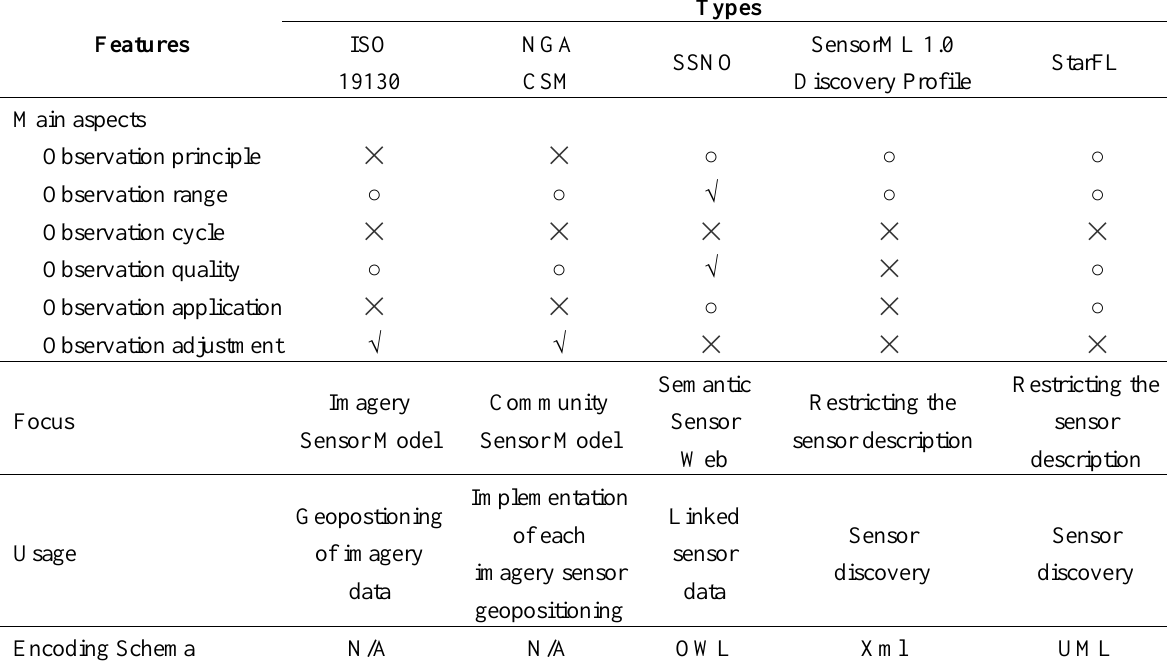
Table 2. Comparisons among existing observation capability-related metadata sets. NGA, National Geospatial-Intelligence Agency; CSM, National Geospatial-Intelligence Agency; SSNO, Semantic Sensor Network Ontology; SensorML, Sensor Model Language; StarFL, Starfish Fungus Language; UML, Unified Modeling